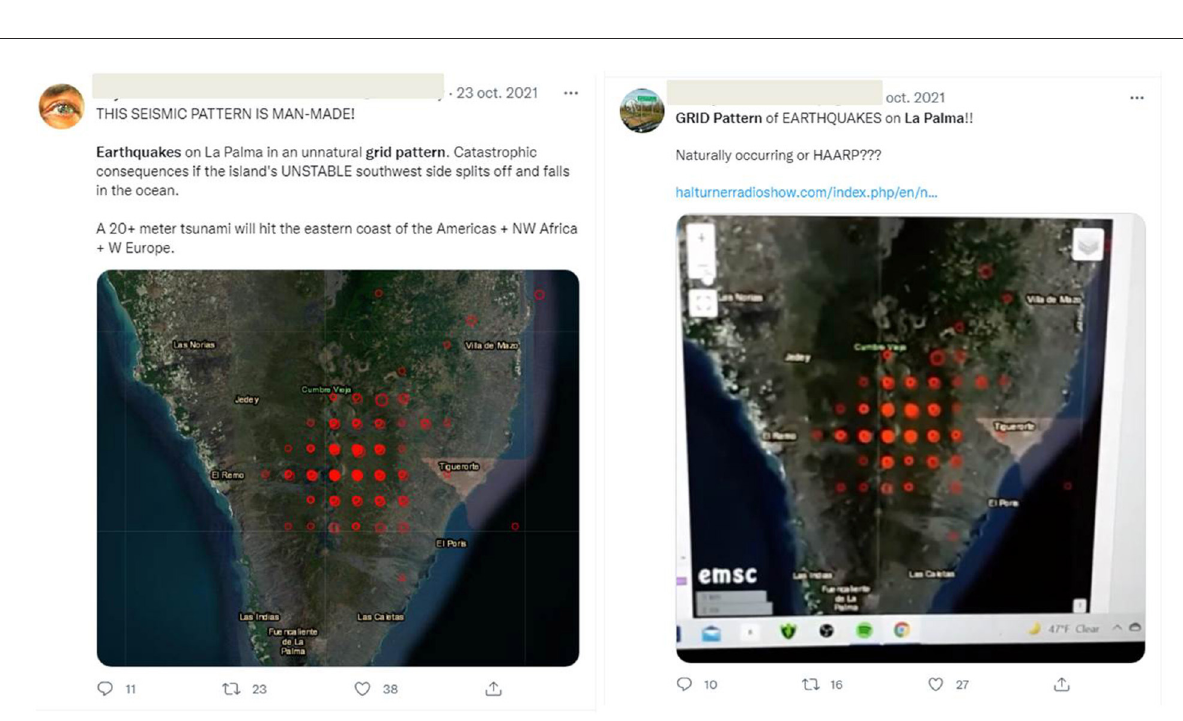
FIGURE2 Screenshots of Twitter users posting the EMSC map to support misinformation about the earthquake grid pattern (Screenshot 17 June